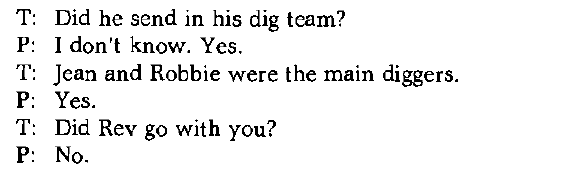
Figure 2 represents schematically the hypothesized relation- ship between fundamental and instrumental processes and their possible pragmatic counterparts.